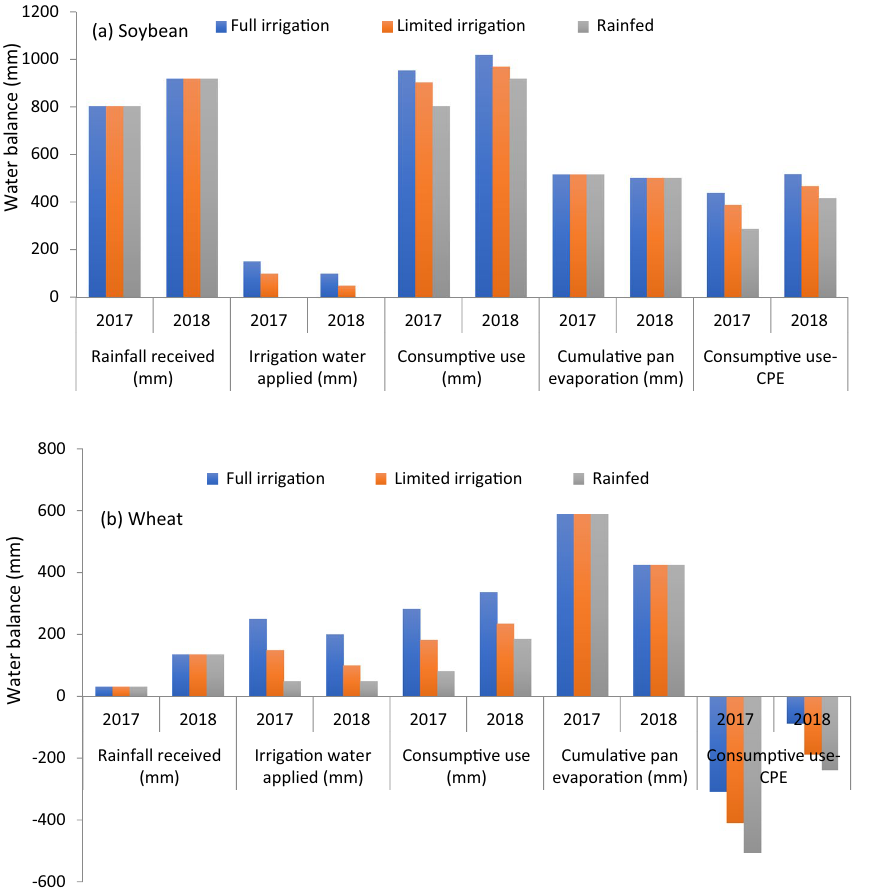
Figure 7. Water balance sheets of ( a ) soybean and ( b ) wheat during 2017–2018 and